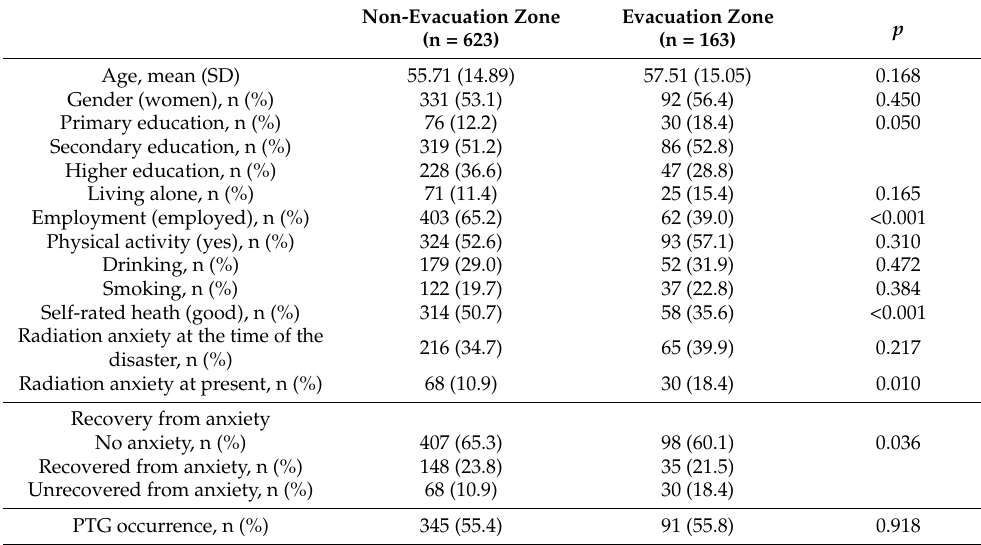
Table 1. Distribution of participants’